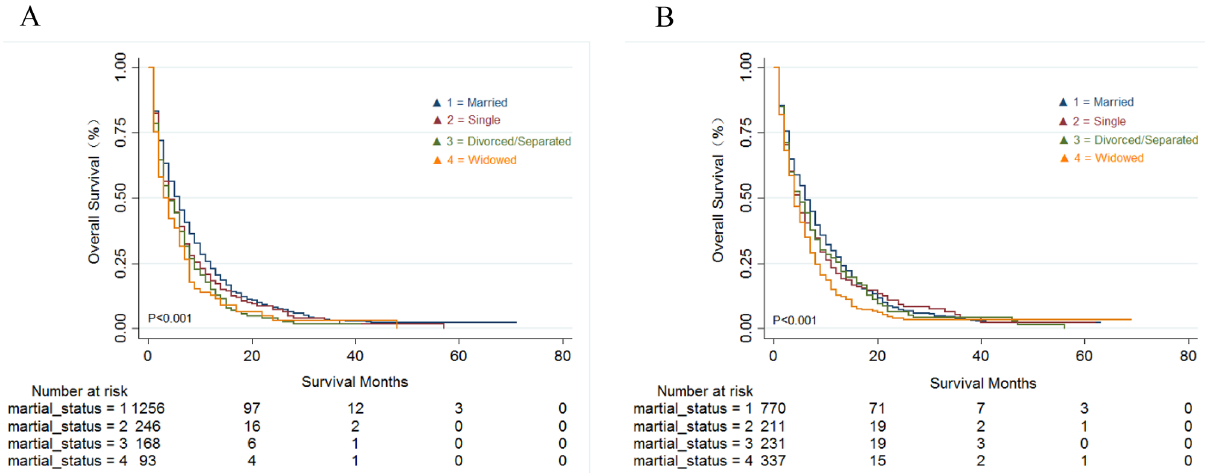
Figure 3. Kaplan–Meier survival analysis of overall survival (OS) in male ( A ) and female ( B ) mPDAC patients with different marital